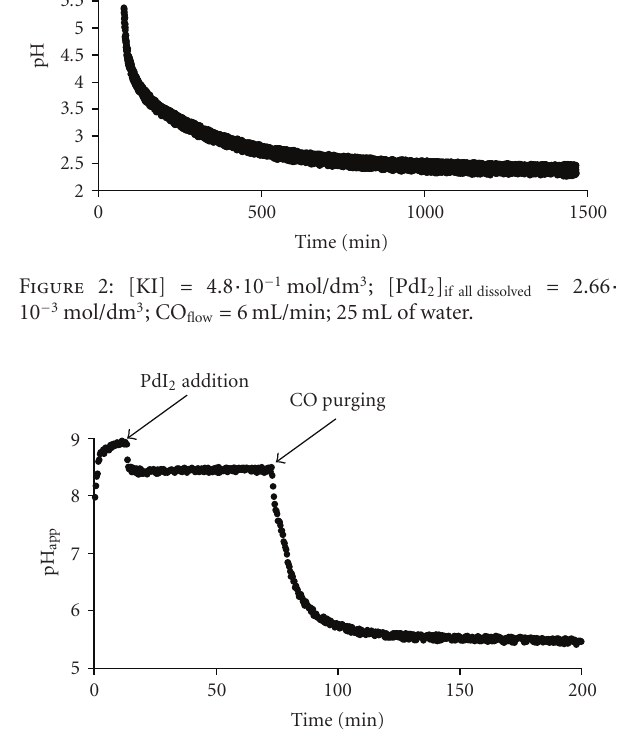
Figure 3: [KI] = 4.8 · 10 − 1 mol/dm 3 ; [PdI 2 ] if all dissolved = 2.66 · 10 − 3 mol/dm 3 ; CO flow = 6mL/min; 25 mL of dry methanol.